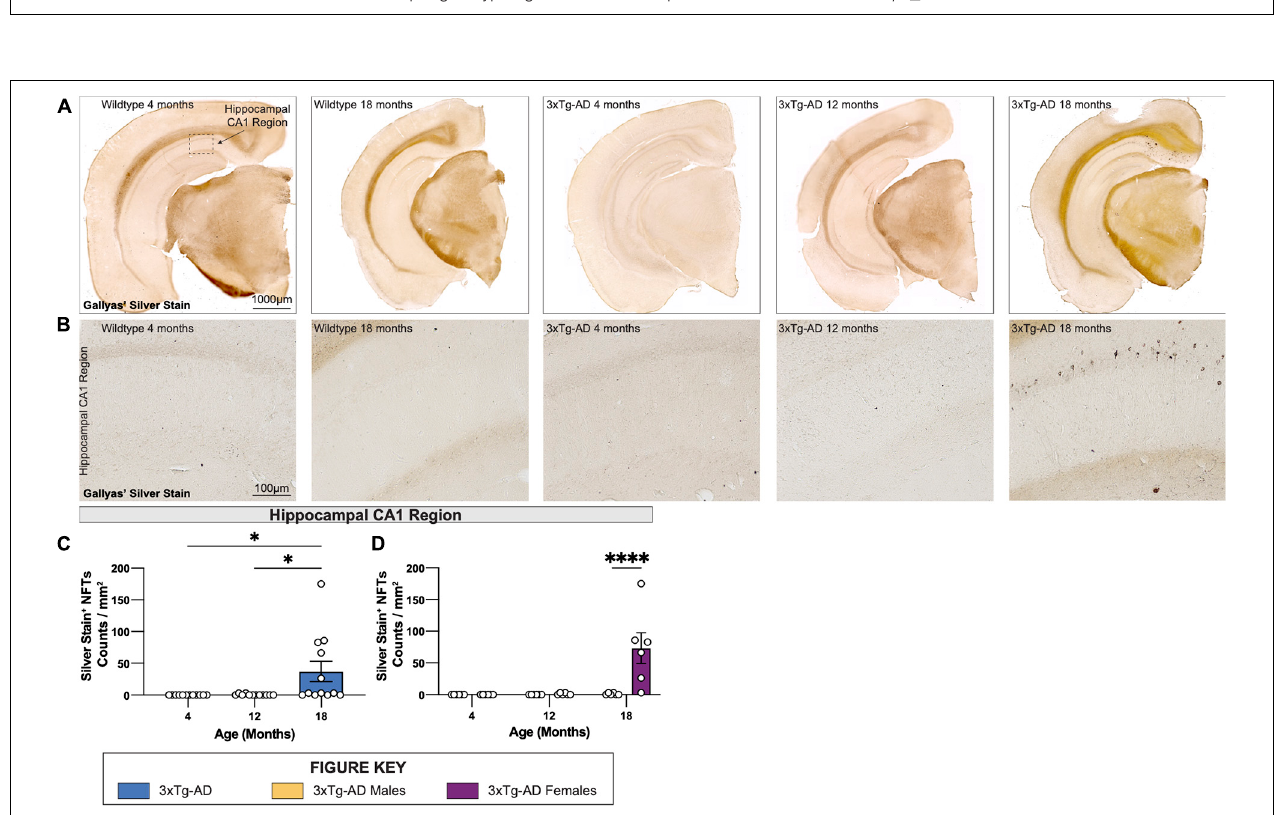
FIGURE 6 | Neurofibrillary tangles increase in number in 18-month-old female 3xTg-AD mice. Accumulation of neurofibrillary tangles (NFTs) was assessed using Gallyas’ silver staining method at each timepoint. (A) Representative stitched brain hemispheres of WT and 3xTg-AD mice at 4- and 18-month, and 4-, 12-, and 18-month timepoints, respectively. (B) Representative brightfield images of silver stained NFTs in hippocampal CA1 regions of WT and 3xTg-AD mice across each timepoint showing progressive accumulation of NFTs. (C,D) Quantification for density of silver stained NFTs in hippocampal CA1 regions per square millimeter by genotype and sex. n = 6 mice per genotype/age/sex. Data are represented as mean ± SEM. ∗ p ≤ 0.05, ∗∗∗∗ p ≤ 0.0001.